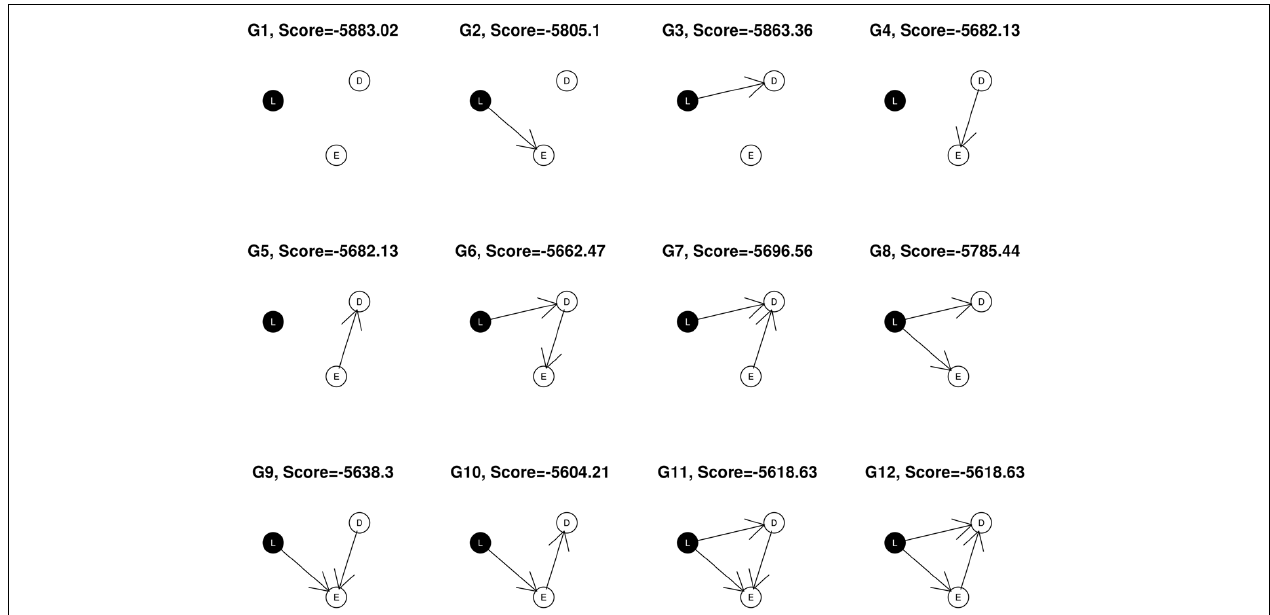
FIGURE 1 | All 12 possible networks for a given ( L, E, D )